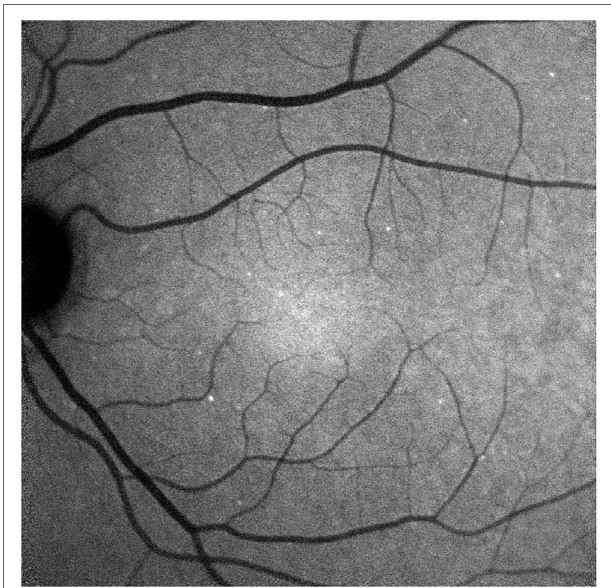
FiGURe 2 | Detection of apoptosing retinal cell (DARC) count in a glaucoma patient. DARC counts are defined as new, unique individual ANX776­labeled spots, at their first appearance in the retina. ANX776 injections revealed single neuronal cell apoptosis in the retina of study subjects, and DARC counts are increased in affected glaucoma patients compared to healthy controls